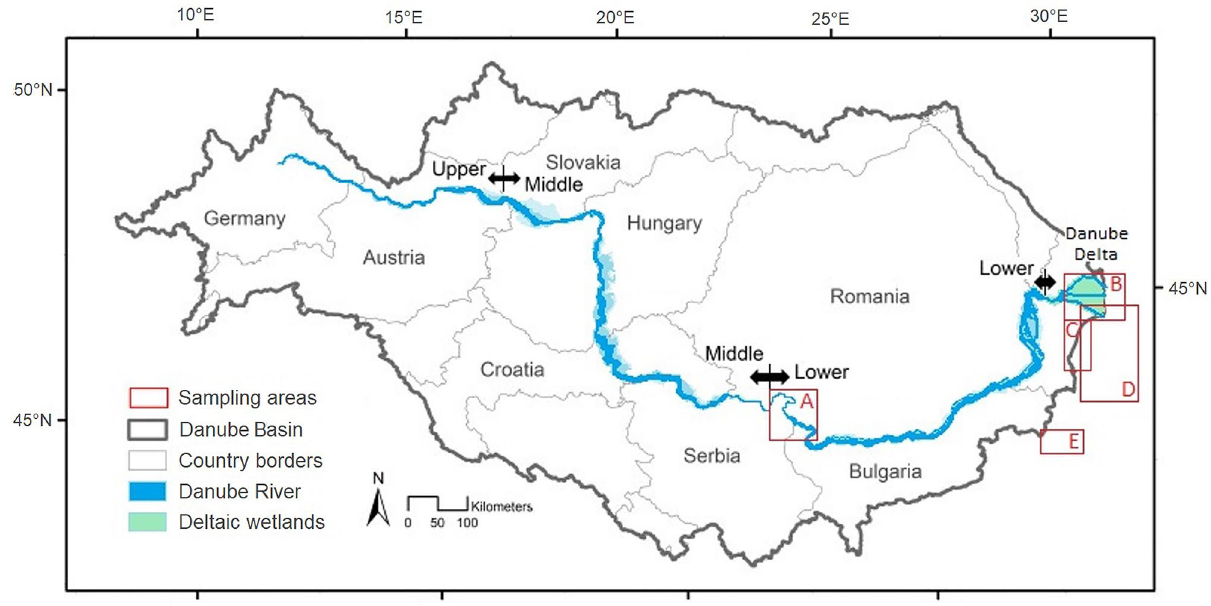
Figure 1. Danube River basin (highlighted) with the marked sampling areas: ( A )—Iron Gates area, ( B )— Danube Delta, ( C )—Black Sea coast, ( D )—Romanian shelf and ( E )—Bulgarian shelf (modified from the ref. 47